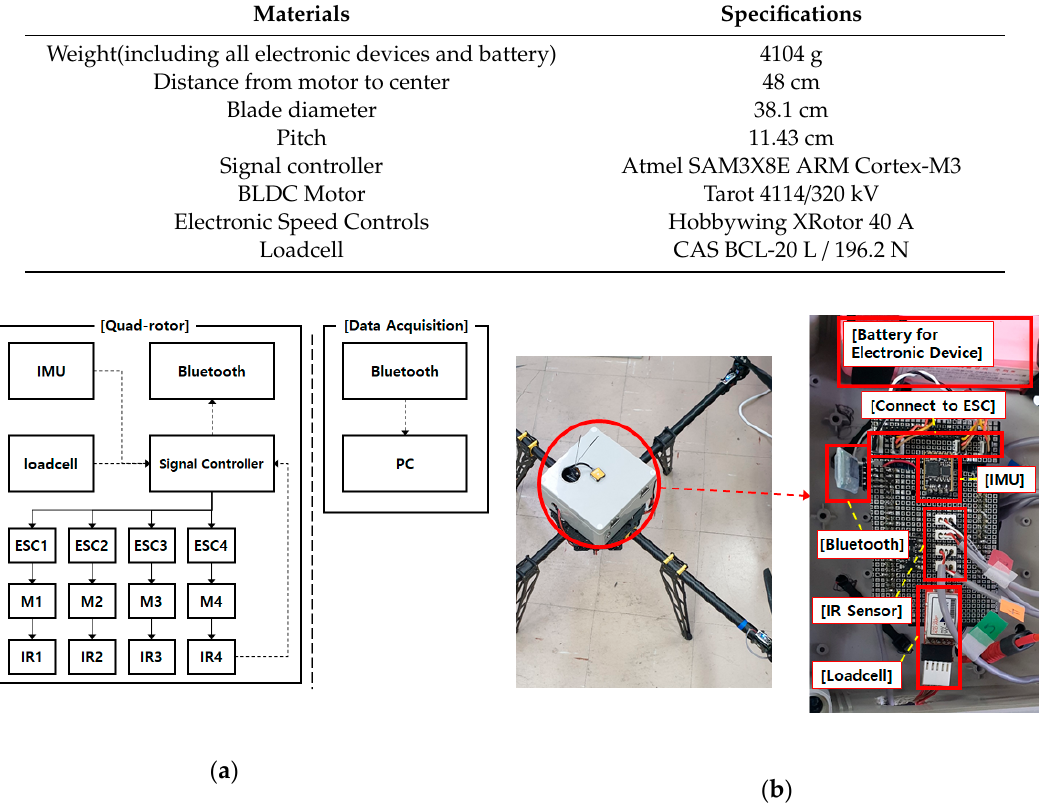
Figure 2. Constituents of quad-rotor for experiments. ( a ) Block diagram for data acquisitions; ( b ) electronic devices of quad-rotor.